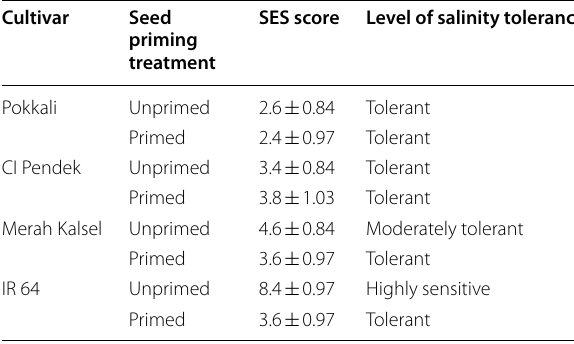
Table 3 Priming reduced salt damage in most tested cultivars Cultivar Seed priming treatment